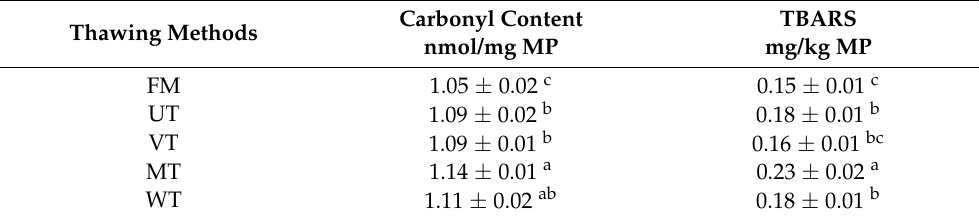
Table 5. Change in carbonyl content and TBARS of porcine longissimus dorsi induced by thawing